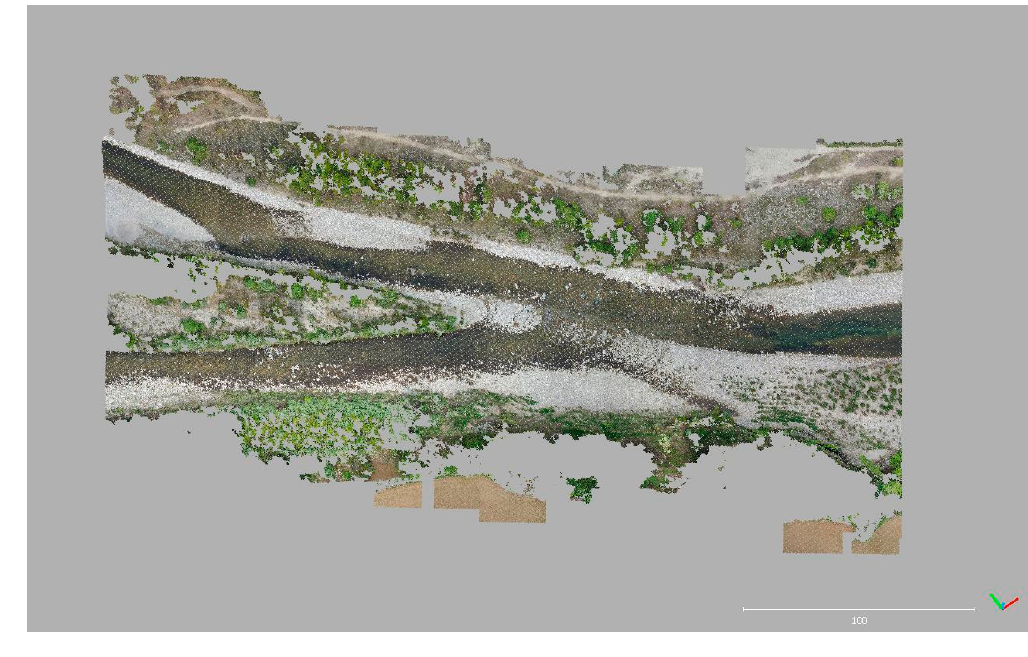
Figure 15. Cont . Remote Sens. 2020 , 12 , x FOR PEER REVIEW